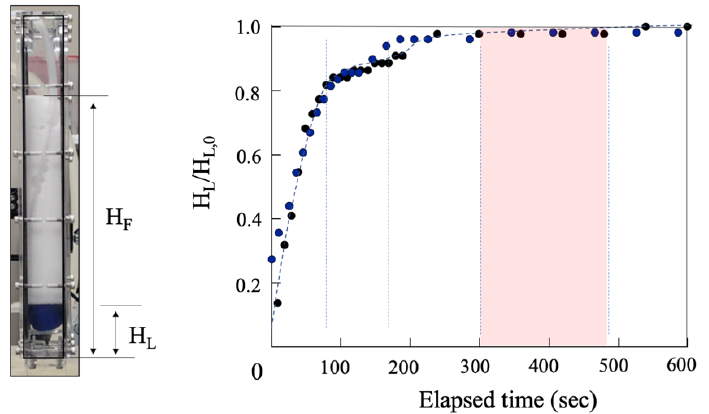
Figure 9. Evolution of height (H L ) of C 12 -EtOH- β Ala solution at the bottom of foaming cell ( right ). Time domain at 300–480 s is indicated in red. The broken line is a guide for the eye. Side view of sample filled with foams and solution ( left ).